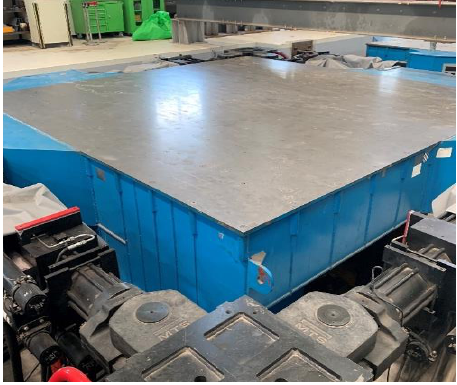
Figure 4. Photograph of the shaking table system used in this study.